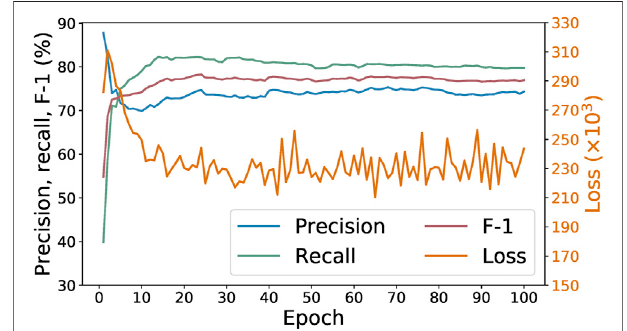
FIGURE 4 | Loss, precision, recall, and F-1 of SpaCy model during training for 100 epochs on 278 paragraphs.